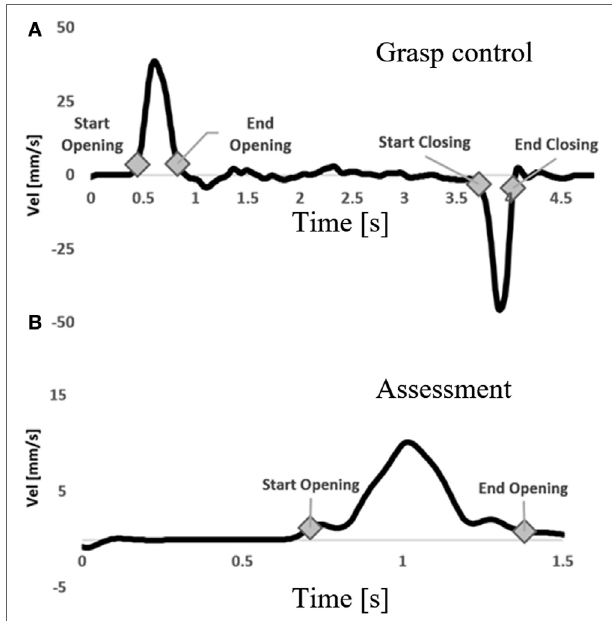
FigUre 2 | Aperture velocity. (a) Grasp control task, start and end of aperture opening and closing marked. (B) Assessment task, start and end of aperture opening